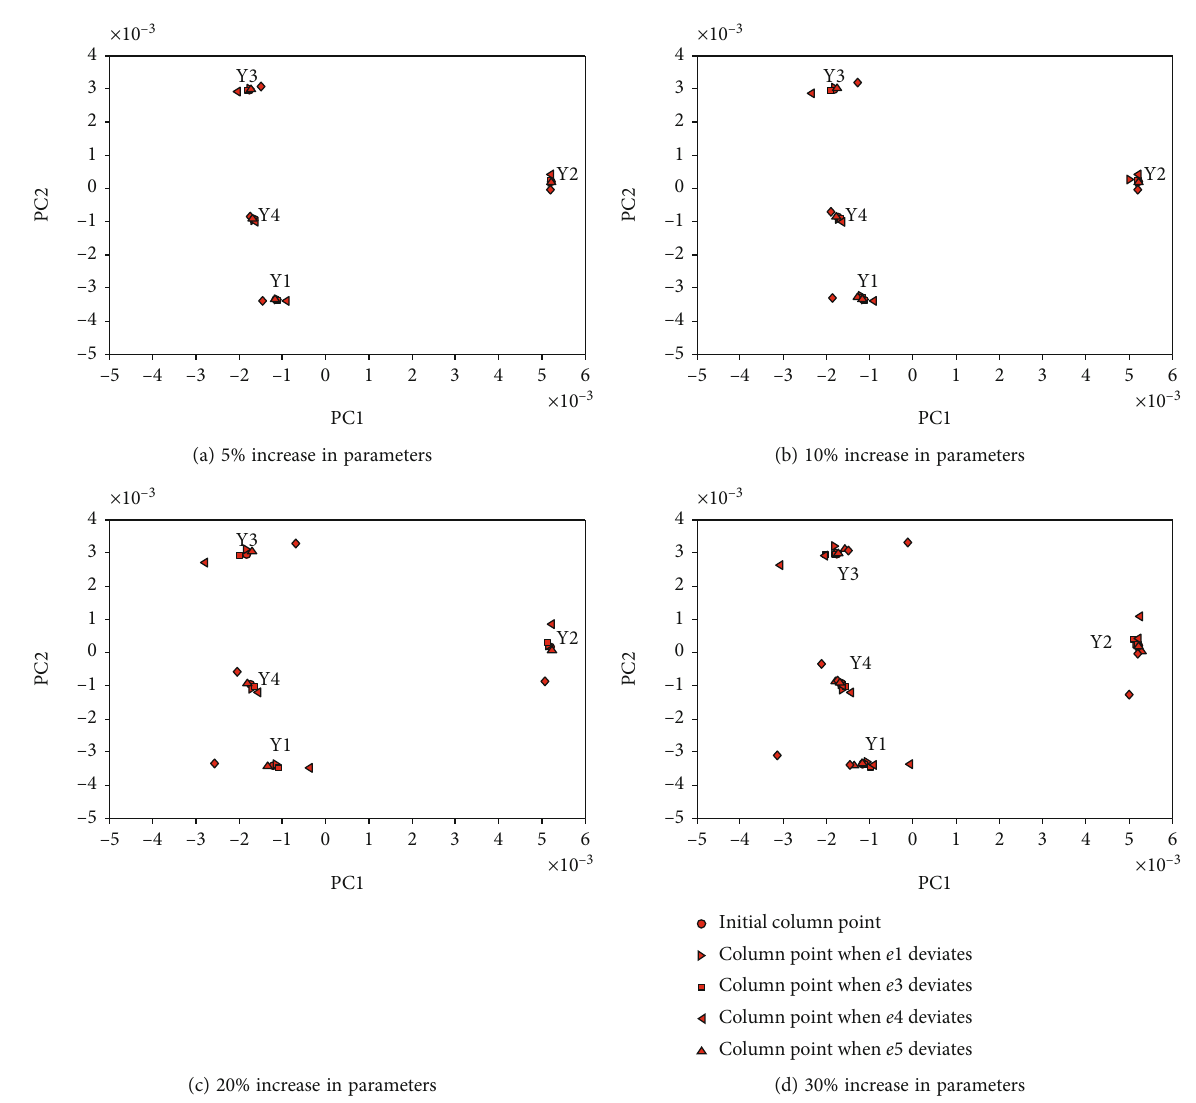
Figure 12: Relative position deviations generated in the safety margin of the work boundary with increase in the key in fl uencing